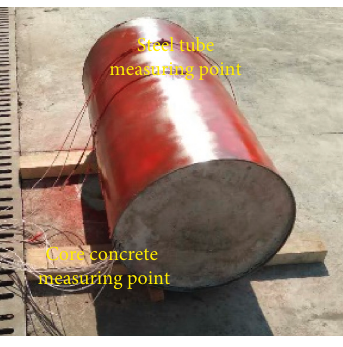
Figure 7: The temperature sensors.